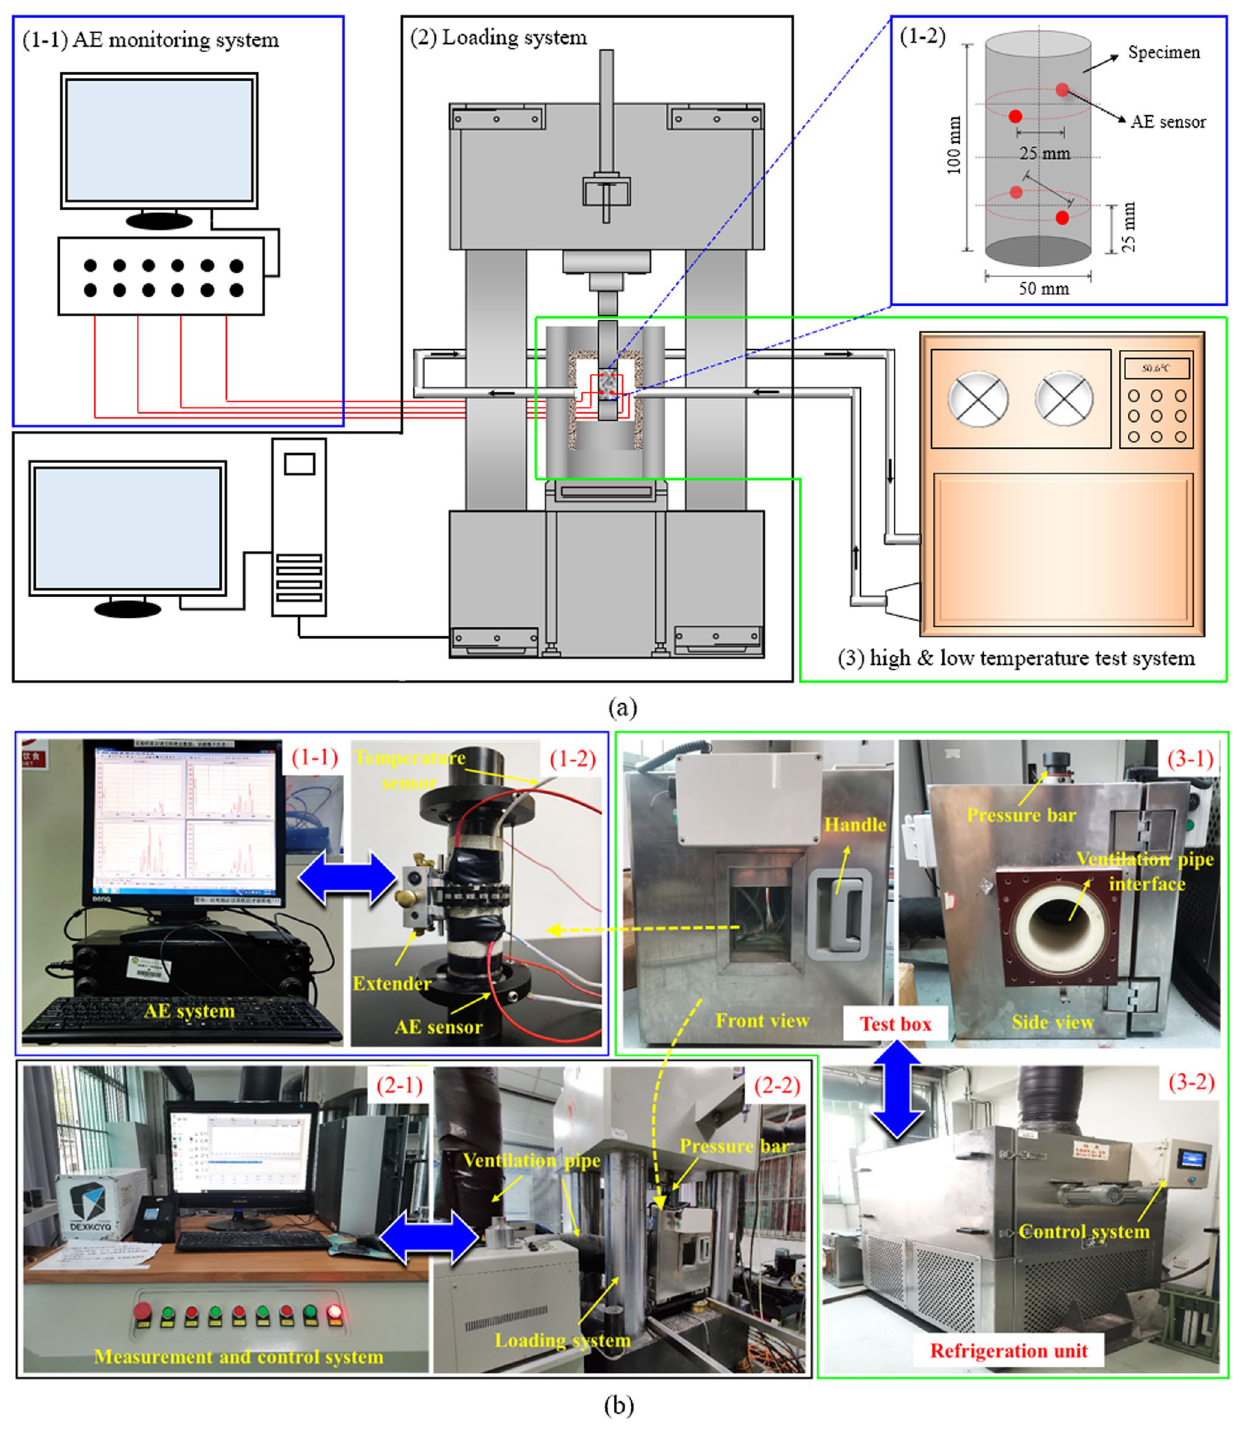
Fig. 1 Experimental platform a Schematic of experimental system b Main test